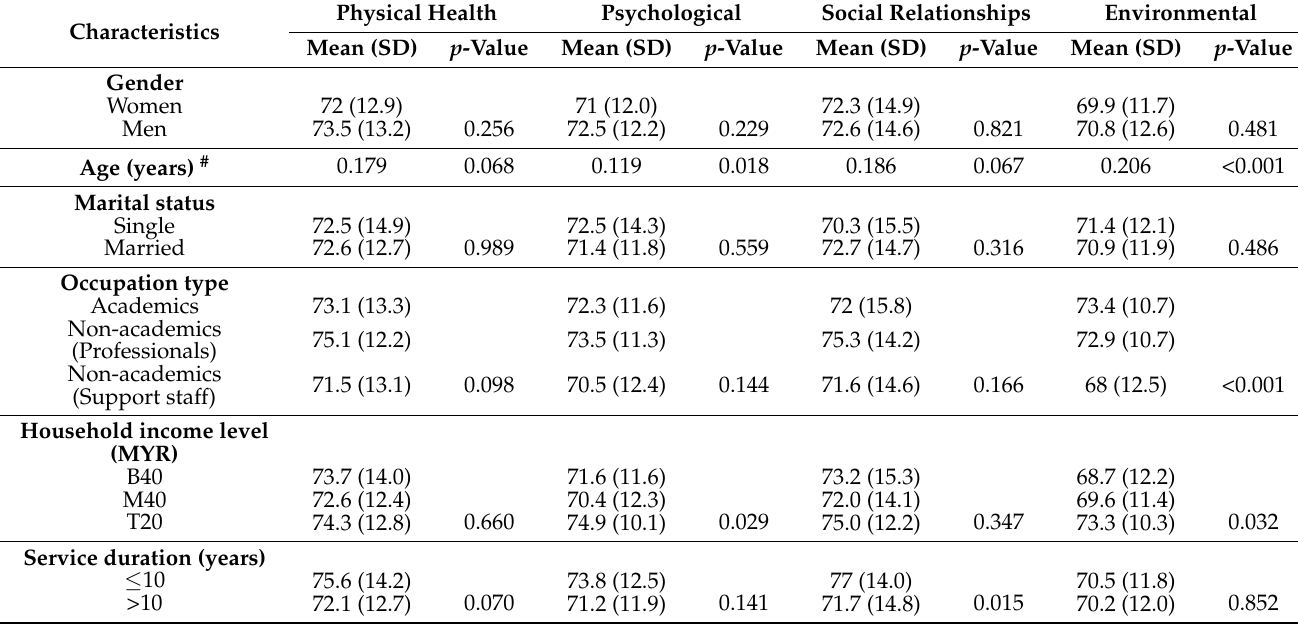
Table 2. Association between HRQoL and socio-demographic characteristics ( n =